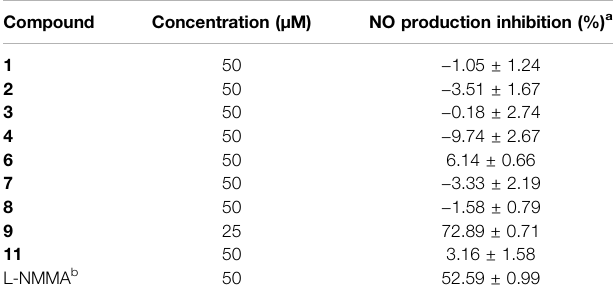
TABLE 2 | AChE inhibitory activity of compound 1. TABLE 3 | Inhibitory activities of compounds 1 – 4 , 6 – 9 , and 11 on LPS-stimulated NO